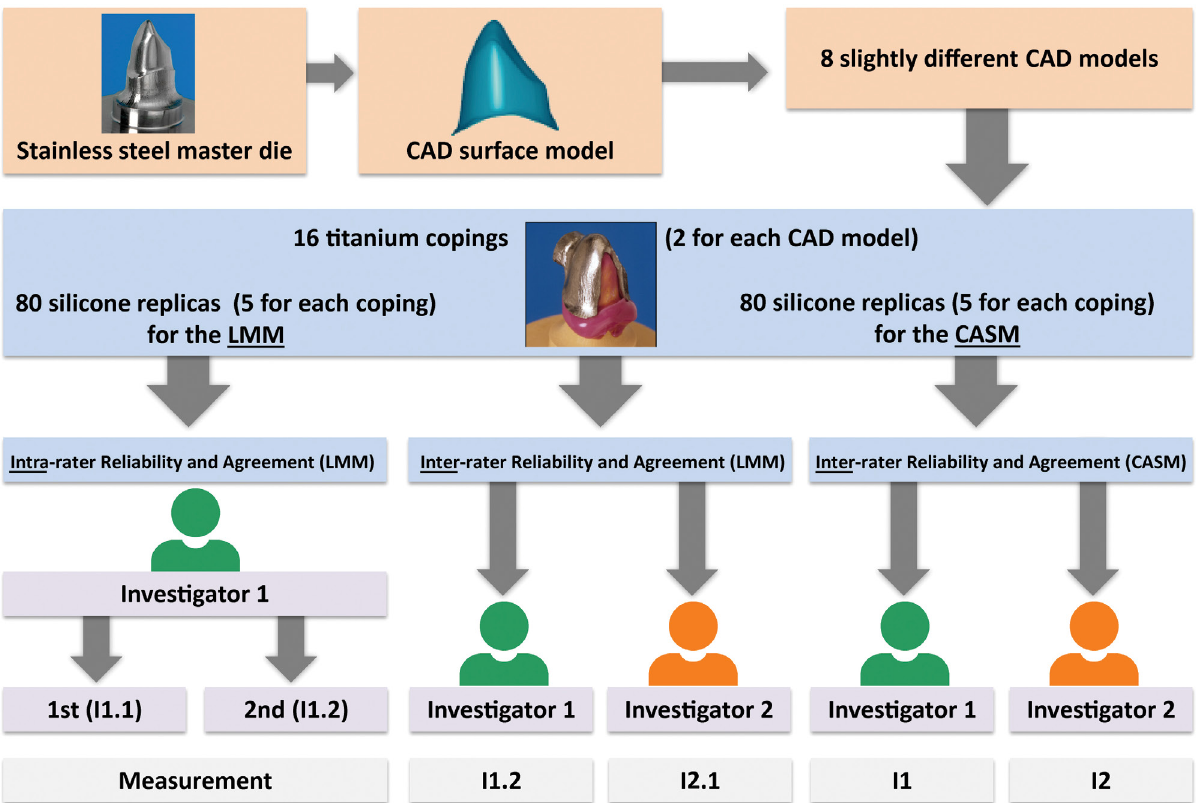
Figure 1- Study protocol; CAD= computer-aided design. LMM= light microscopy measurement; CASM= computer-assisted measurement; I1.1 and I1.2= first and second measurements of the first investigator (LMM); I2.1= measurement of the second investigator (LMM); I1 and I2= measurements of the first and second investigators